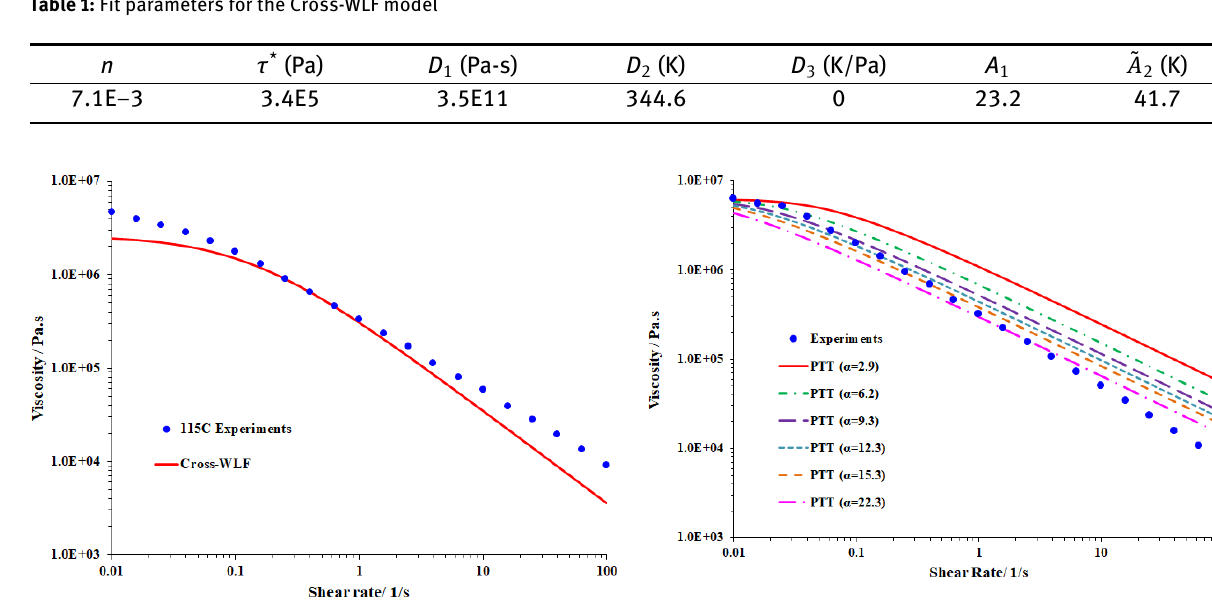
Table 1: Fit parameters for the Cross-WLF model